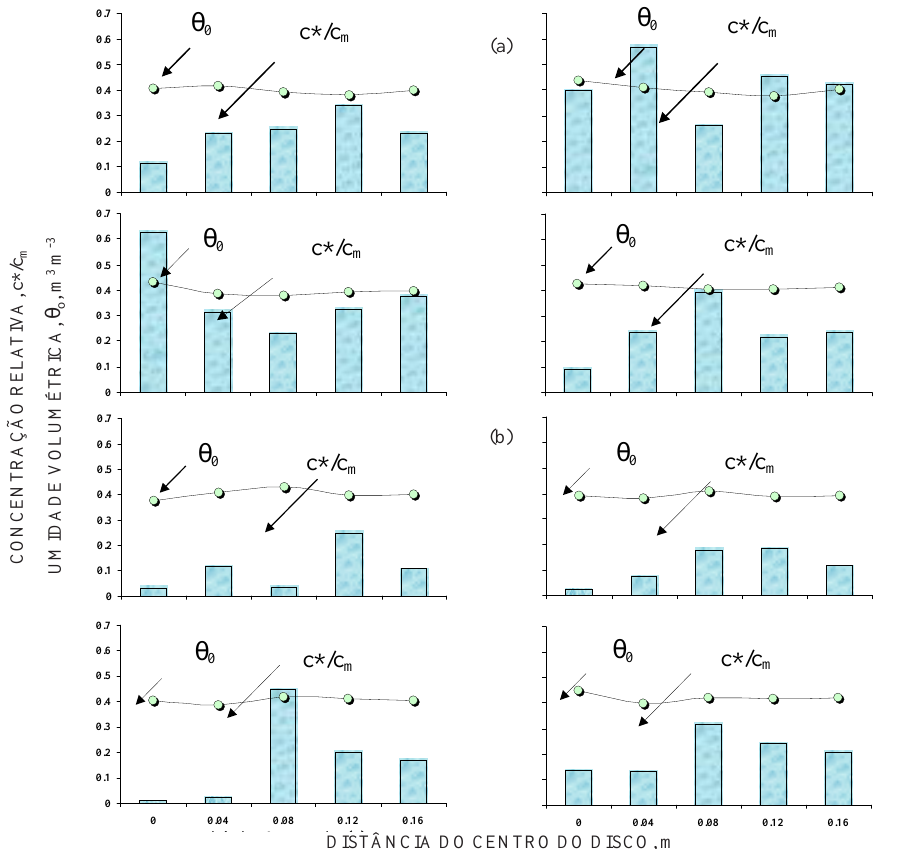
DISTÂNCIA DO CENTRO DO DISCO, Figura 3. Concentração relativa de Cl - (c*/c ) e umidade volumétrica total ( qqqqq ) medidas sob o permeâmetro m de disco, ao final da infiltração. (a) Primeira etapa do experimento (segundo semestre de 1997), concentração aplicada = 0,1 mol L -1 ; (b) Segunda etapa do experimento (primeiro semestre de 1998), concentração aplicada = 0,05 mol L -1 . Parcela E2.